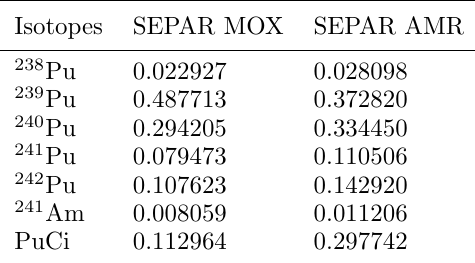
Table 9. SEPAR fresh fuel Pu vector for the UOX - MOX - AMR option (heavy metal weight